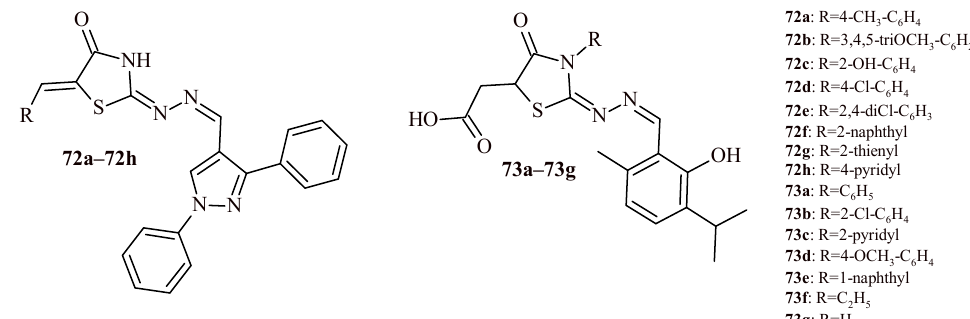
Figure 29. Thiazolidin-4-one derivatives containing pyrazole and thymol moieties with anti-inflammatory activity.